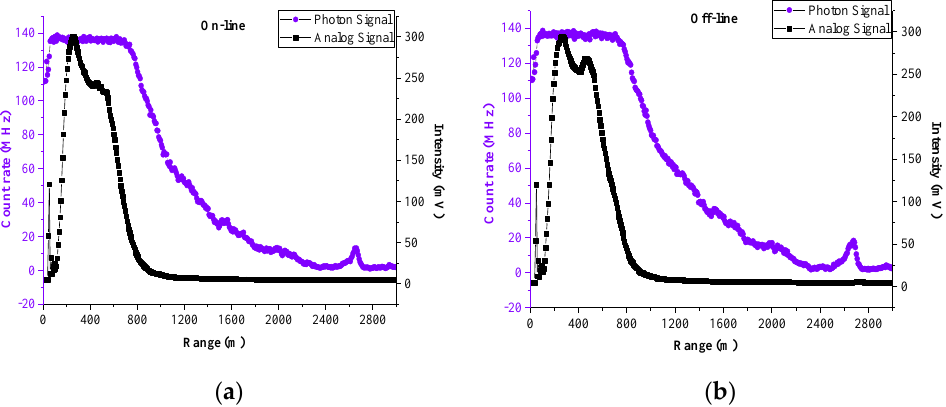
Figure 6. Original signal diagram of AD and PC signals (3 May 2016), ( a ) and ( b ) are online wavelength and offline wavelength, respectively.